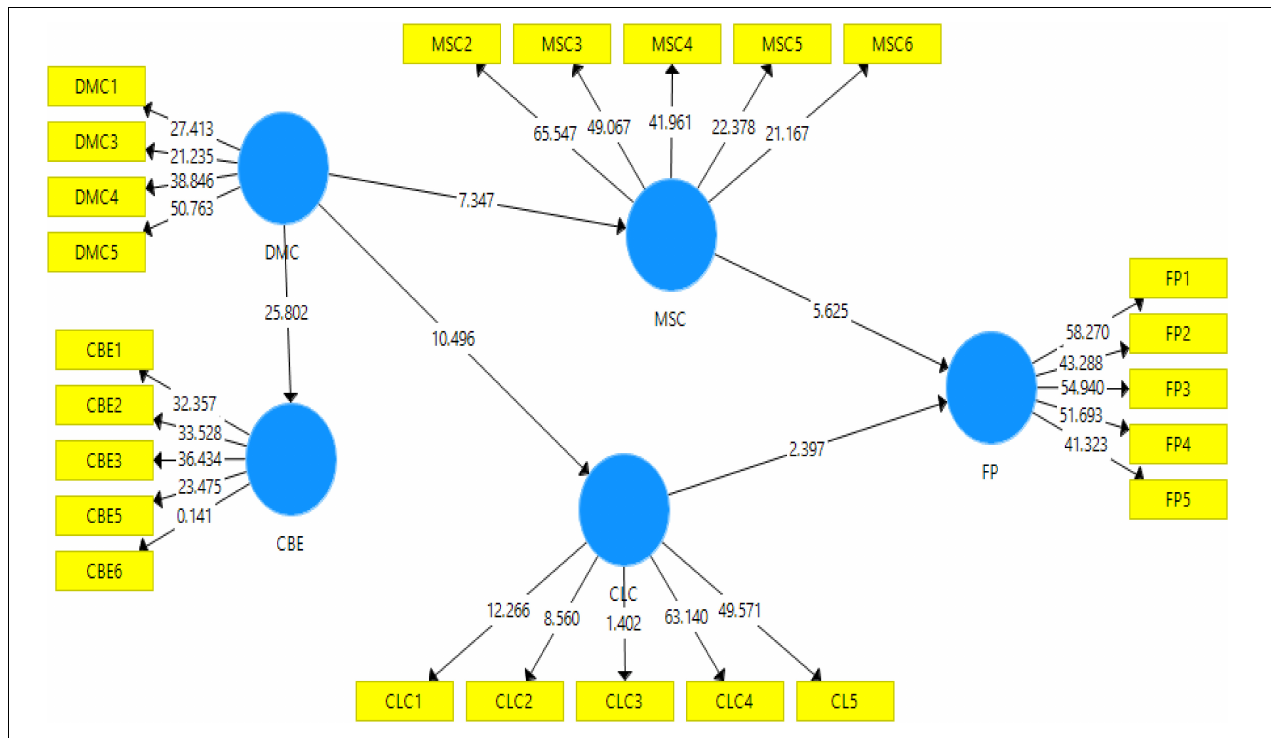
FIGURE 3 | Structural equation model.